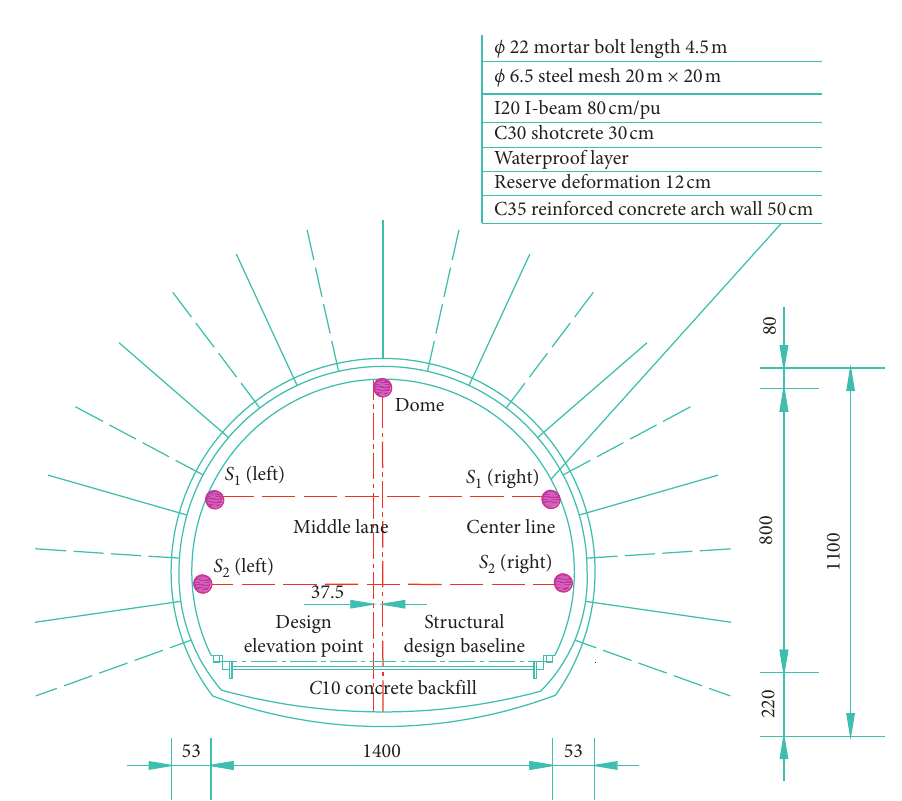
Figure 2: Schematic diagram of measuring point layout (unit: